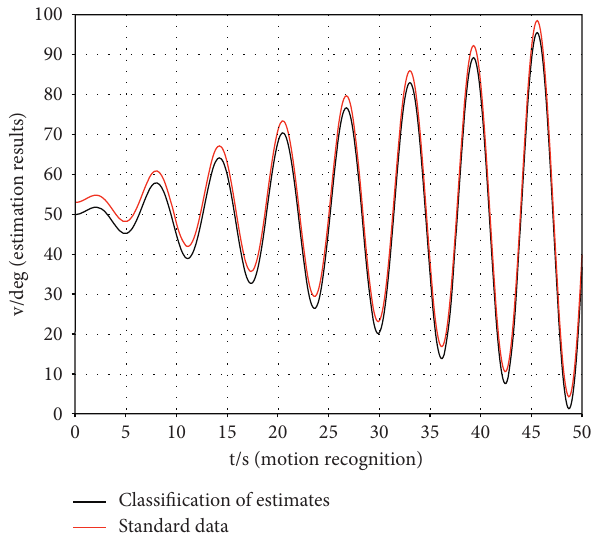
Figure 6: Ballistic estimation results under the condition of motion behavior